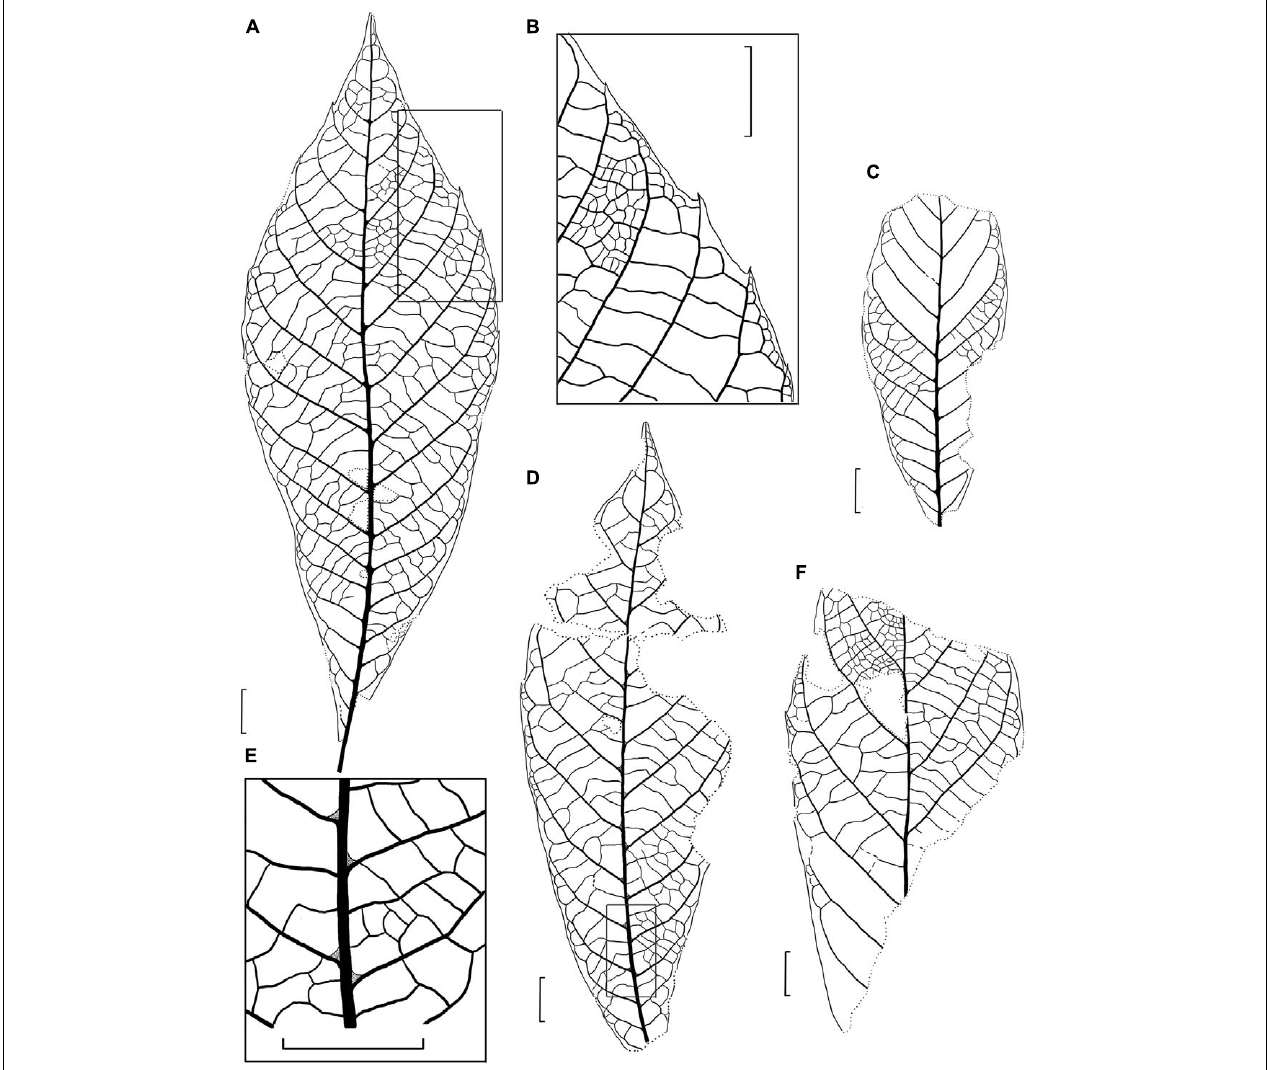
FIGURE 4 | Drawings of the fossil leaves of M. eosinica sp. nov. from the Huangniuling Formation of the Maoming Basin, South China. (A) Holotype, MMJ3-008-1a. (B) Higher magnifications of the venation near the leaf margin in (A) . (C) Leaf with untoothed margin, MMJ3-2207-2. (D) Leaf with untoothed margin, MMJ3-2175-1a. (E) Higher magnifications of the leaf domatia and venation near midvein in (D) . (F) Incomplete leaf, MMJ3-837-3a. Scale bars = 1